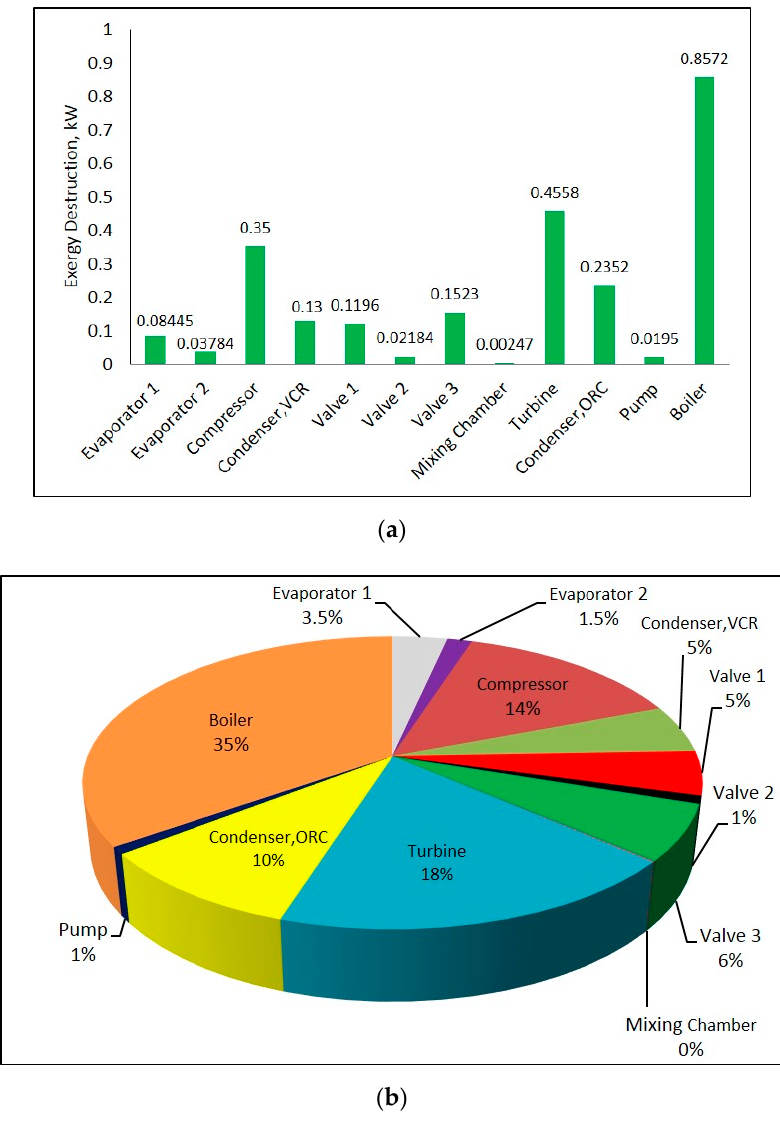
Figure 17. Exergy destruction rate ( a ) and exergy destruction ratio ( b ) of components in combined ORC-dual evaporator VCR cycle.